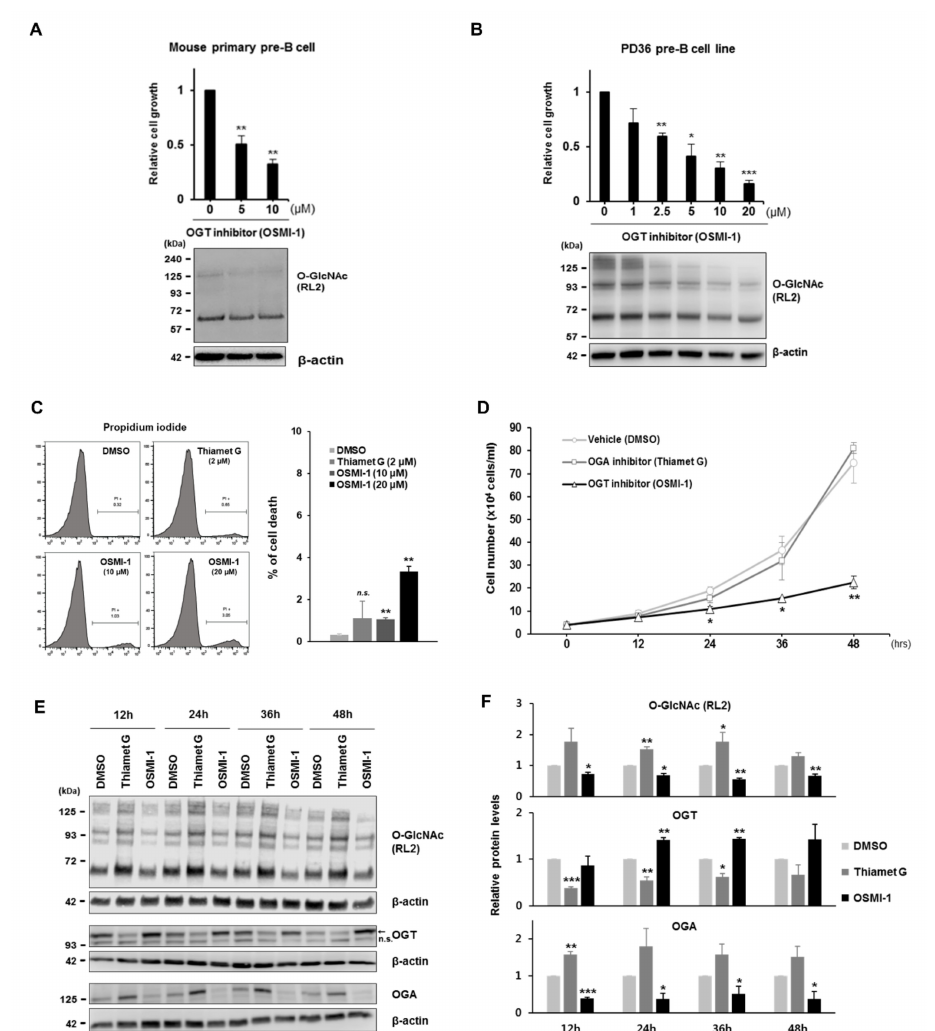
Figure 2. Proliferation of large pre-B cells expressing pre-BCR is significantly decreased by inhibition of O-GlcNAcylation. ( A , B ) Relative cell number after a 48-h culture using di ff erent doses of OSMI-1 (OGT inhibitor) and normalized against DMSO (vehicle control; 0 µ M). Data are represented as mean ± SD ( n = 3). Comparison of OSMI-1 treatment at each dose with DMSO treatment. Representative western blot (bottom) to monitor decreased O-GlcNAcylation. ( A ) Mouse primary pre-B cells were sorted using the pre-BCR expression as a marker. ( B ) Pre-BCR-expressing pre-B cells, PD36. ( C ) Representative plot showing data from flow cytometric analysis of cell death in PD36 pre-B cells stained with propidium iodide at 48 h post-treatment with inhibitors [Thiamet G (OGA inhibitor; 2 µ M, final) and OSMI-1 (10 or 20 µ M, final)] (left). Quantification of the percentage of propidium iodide-positive cells as dead cells (right). Data are represented as mean ± SD ( n = 3). Comparison of each treatment with DMSO-treated control. n.s. = not significant. ( D ) Cell growth of PD36 pre-B cells for 48 h following inhibitor treatment [Thiamet G (2 µ M final) and OSMI-1 (10 µ M final)]. The growth curve was generated by counting cells every 12 h. Data are represented as mean ± SD ( n = 3). Comparison of OSMI-1 treatment with that of the DMSO control at each time point. ( E ) Representative western blot to monitor changes in O-GlcNAcylation, OGT, and OGA levels at each time point. ( F ) Quantification of data from western blot results in ( E ). Data are represented as mean ± SD ( n = 3) normalized using β -actin as a loading control. Comparisons were performed using the DMSO control at each time point. ( A – D , F ) Significance is annotated as * p ≤ 0.05, ** p ≤ 0.01, and *** p ≤